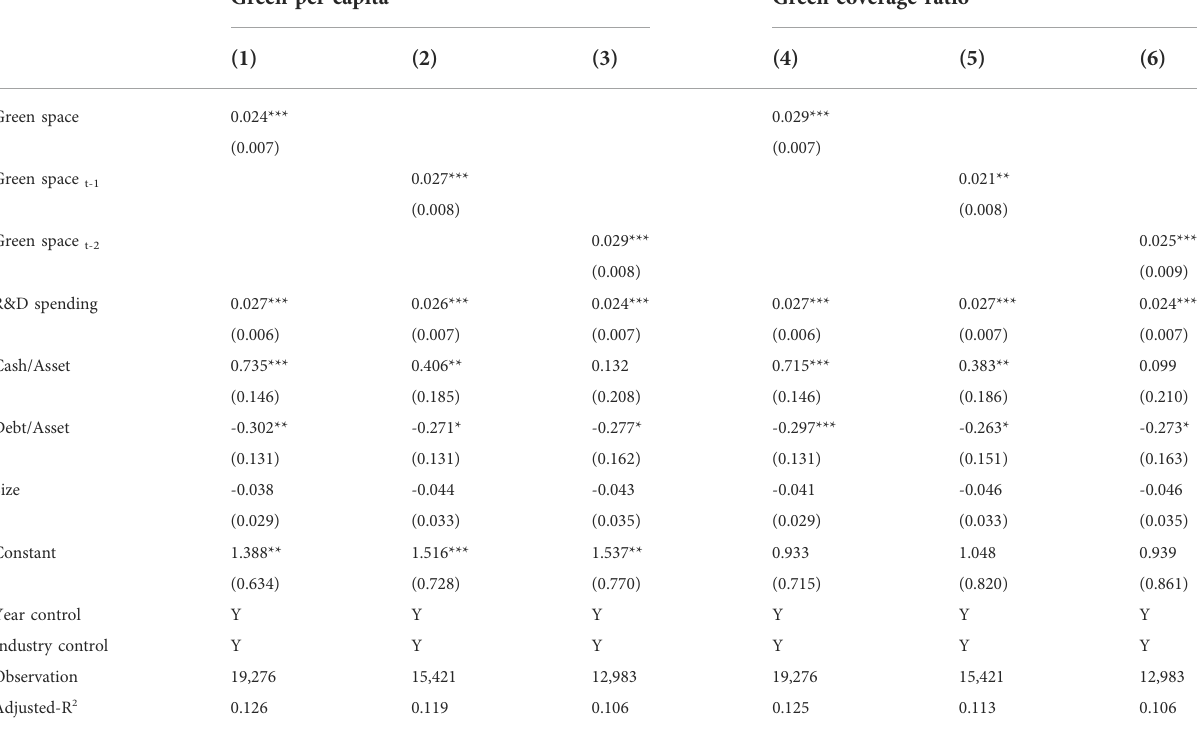
TABLE 7 The effect of green spaces on innovation.